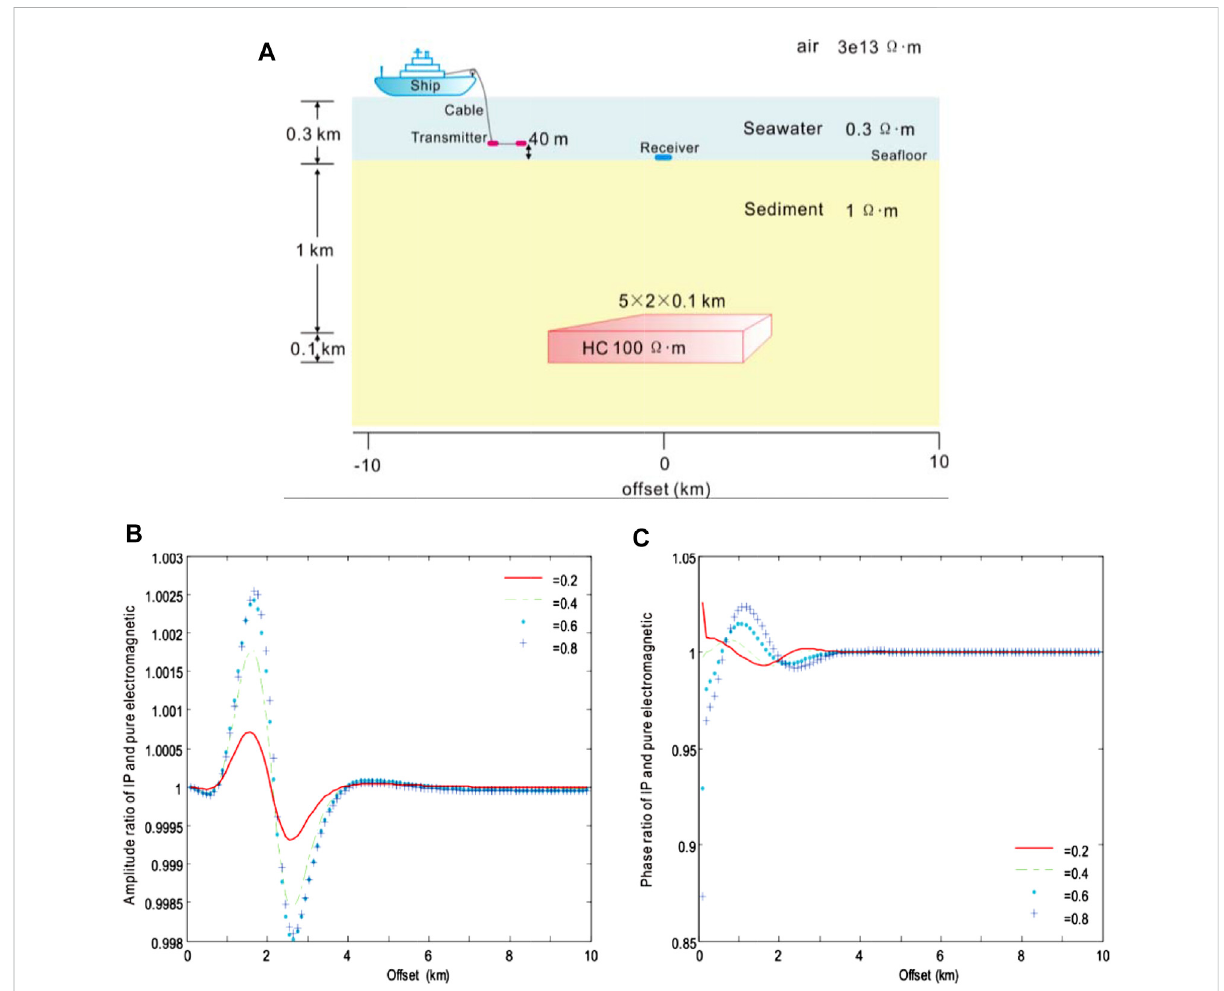
FIGURE 11 AmplitudeandphaseratioofCSEMwiththeIPandpureelectromagnetic fi eldtotheDiasmodelofvariousvolumepercentages δ =0.2(red),0.4 (green),0.6(blue)and0.8(lightblue),respectively. (A) Geoelectricmodelofsubmarinehydrocarbonswithion-inducedpolarizationinthe3Dmarine CSEM, (B) the ratio of amplitude, and (C) the ratio of